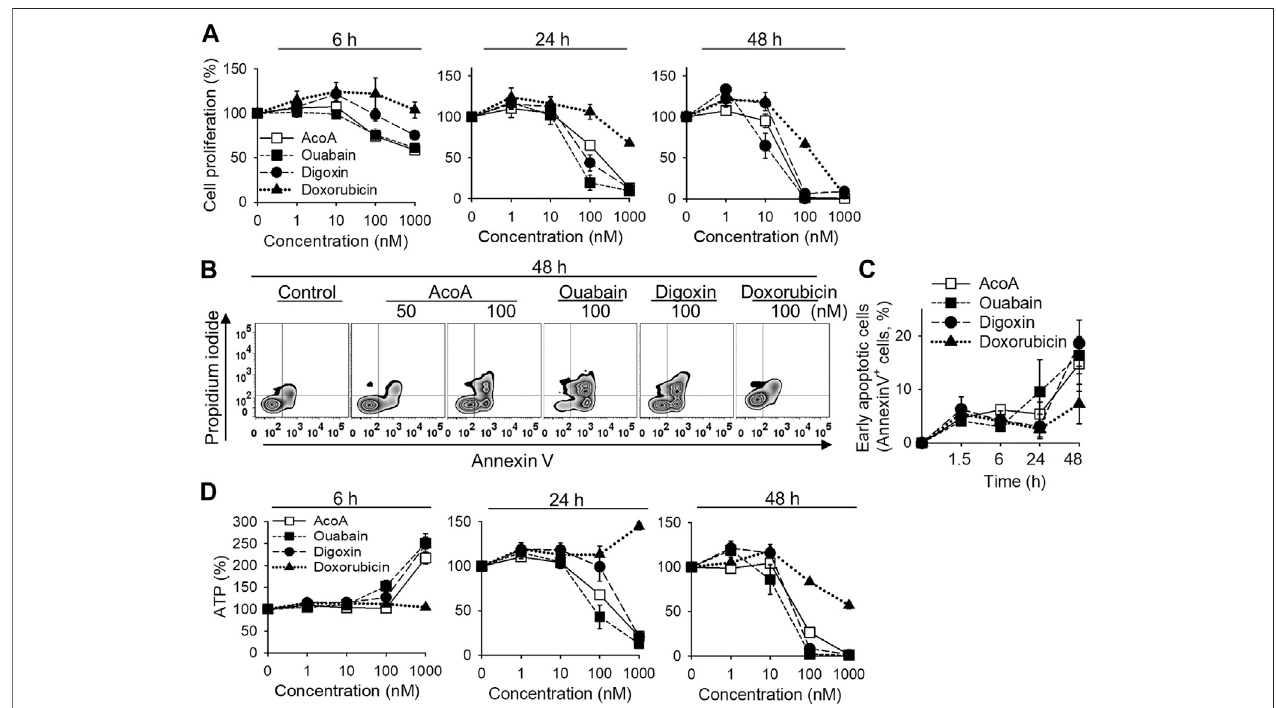
FIGURE 2 | AcoA induces apoptosis in A549 lung carcinoma cells in vitro . (A ) A549 lung cancer cells were treated with different concentrations of AcoA, ouabain, digoxin,ordoxorubicinandcellviabilitywasmeasuredbyXTT. (B) Todetectapoptosis,A549cellswerestainedwithFITC-annexinVandpropidiumiodideandanalyzed by fl ow cytometry. The graph shows representative fl ow cytometry histograms after 48 h incubation with the respective compounds. (C) Percentage of early apoptotic cells (annexin V + , PI − ). (D) Effect of AcoA, ouabain, and digoxin on ATP levels in A549 cells. ATP in luciferase-expressing A549 cells was analyzed after addition of luciferin. All data are mean ± SEM of N (cid:1) 3 independent experiments performed in